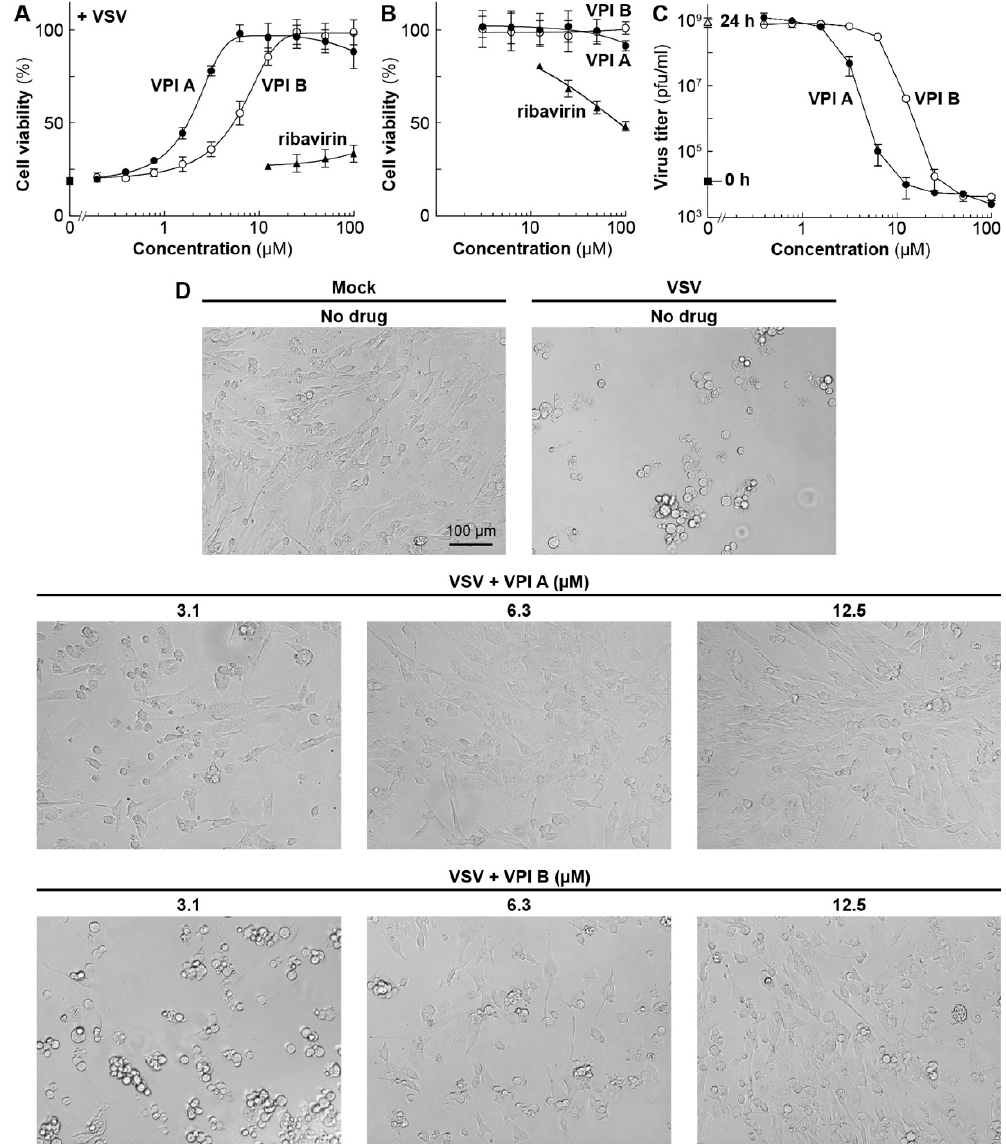
Figure 2. Anti-VSV activities of VPIs A and B in BHK-21 cells. BHK-21 cells in 96-well plates were mock-infected or infected with VSV at an MOI of 0.1 in the presence or absence of different concentrations of VPI A (closed circles), VPI B (open circles), or ribavirin (closed triangles), and cultured for 24 h. The viability of infected ( A ) or mock-infected ( B ) cells was assessed by the CCK assay. The viability of mock-infected cells (no drug) was set to 100%. Symbols and error bars represent the means and standard deviations, respectively, of three independent experiments, which were conducted in triplicate. In ( A ), the viability of infected cells (no drug) is shown by a closed square. VSV titers (plaque-forming units (pfu)/mL) of culture supernatants at 24 h post-infection were determined by a plaque assay ( C ). Symbols and error bars indicate the means and standard deviations, respectively, of three experiments. VSV titers of culture supernatants at 0 h and 24 h post-infection (no drug) are shown by a closed square and open triangle, respectively. The mock-infected or infected cells in the presence or absence of VPI A or B at various concentrations were observed under a microscope ( D ).